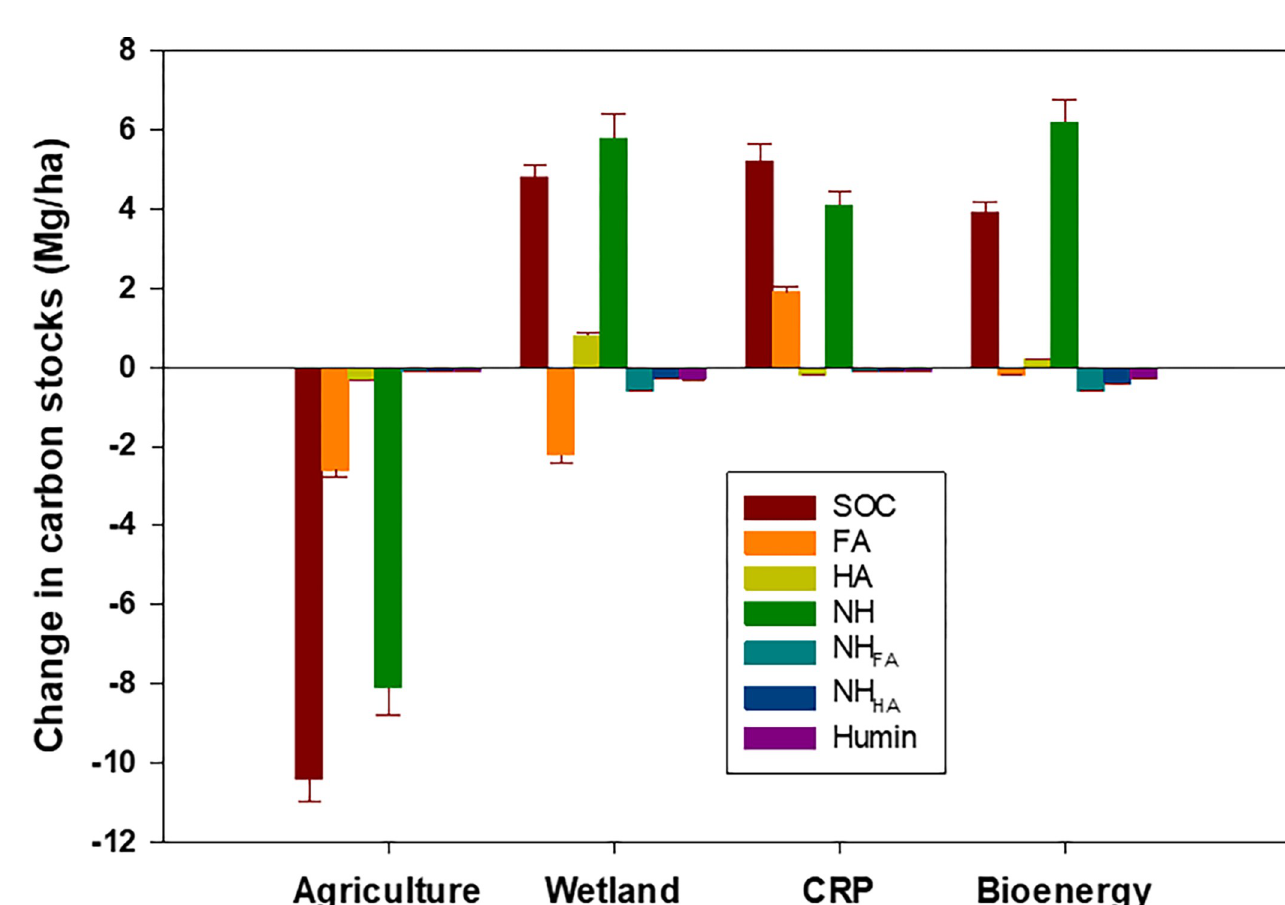
under bioenergy. The FA stock, in contrast, consistently decreased under agriculture and wet- land but increased under the CRP and bioenergy compared to forest. The NH, FA HA stocks under forest were statistically similar with agriculture, and the CRP, but signifi- NH cantly lower under wetland.